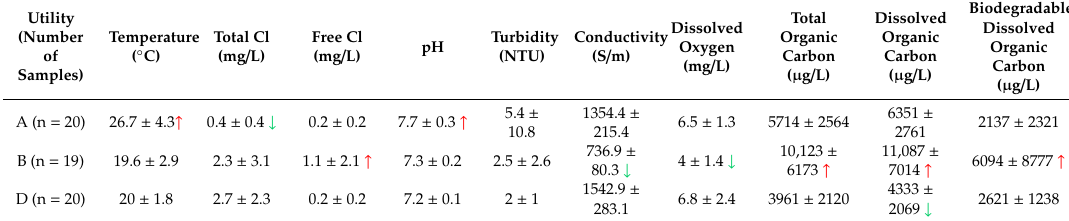
Table 1. Water quality (average ± standard deviation) for the reclaimed water collected at sites A, B and D. Red arrow denotes significantly higher parameters at that site compared to other sites, while green denotes significantly lower. Data was obtained from earlier study by Garner et al. [12] for further statistical